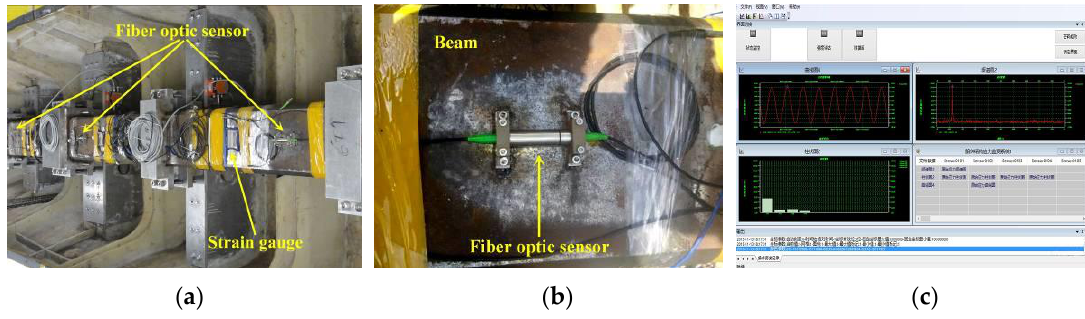
Figure 17. The structural safety monitoring system: ( a ) arrangement of sensors; ( b ) the fiber optic sensor on the backbone surface; and ( c ) interface of monitoring software.